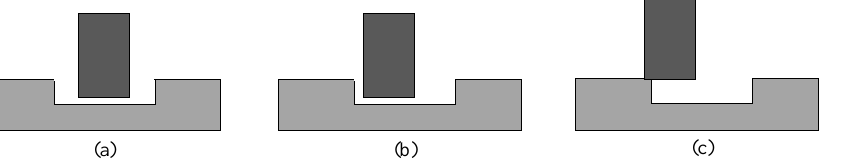
Figure 4. Schematic diagram of gap size: ( a ) gap size is normal. ( b ) gap size is too large or too small. ( c ) indicator piece could not fall into notch.